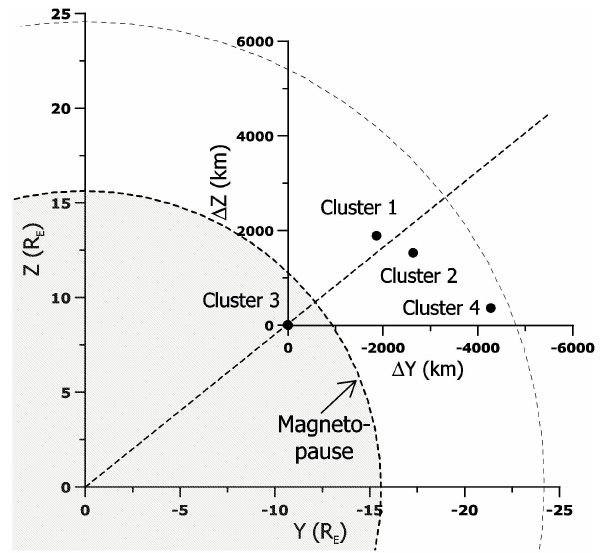
Fig. 7. The Cluster 3 position projected over the YZ plane, and the Cluster 1, 2 and 4 positions as pairs of ( 1 Y, 1 Z) in refer- ence to Cluster 3 are shown. The ideally circular magnetopause surface is drawn with thick-dashed line and encloses the Cluster 3 site throughout the studied event, except for the short intervals that coincide with the occurrence times of the three solar wind pressure